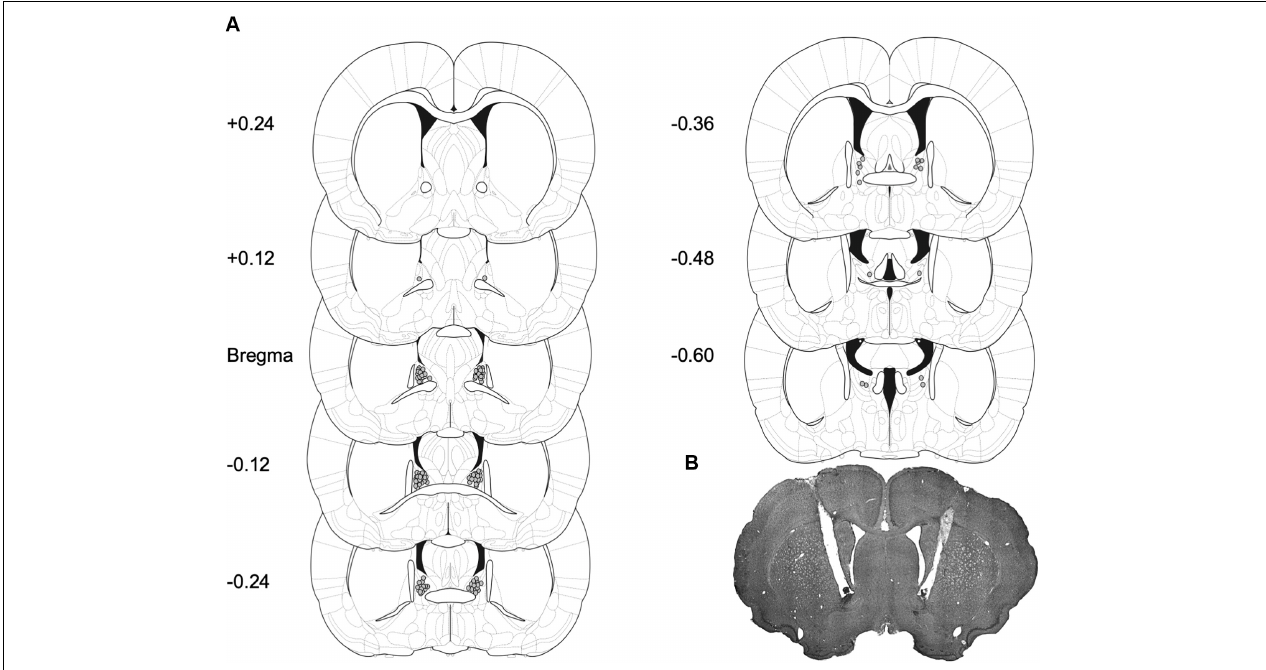
FIGURE 4 | Placement for injector tips in rats with BNST cannulae implants. (A) Gray dots represent sites of R121919 infusions on coronal sections as a distance from Bregma (mm). Drawings are adapted from Paxinos and Watson (2007). (B) A representative brain section depicting cannulae placement in the